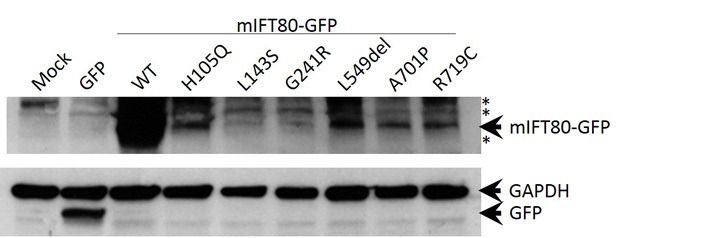
Western blot analysis of wild-type and missense mutant forms of mIFT80-GFP.Mock and GFP transfected cells serve as controls distinguishing specific and non-specific bands. Arrowheads indicate specific bands at 26.9 kDa (GFP), 37 kDa (GAPDH) and 106.9 kDa (mIFT80-GFP). GAPDH serves as a loading control. Asterisks indicate non-specific bands present in control lanes.